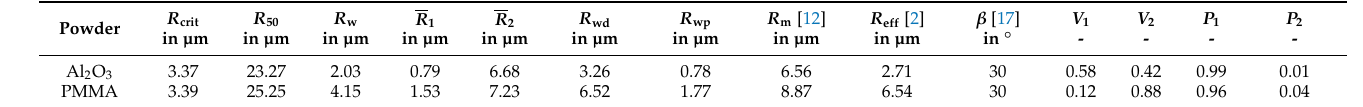
Table 2. Values for the determination of the modified pore radius, the calculated weighted radius R w , and the calculated pore radii applying the equations given in the literature.